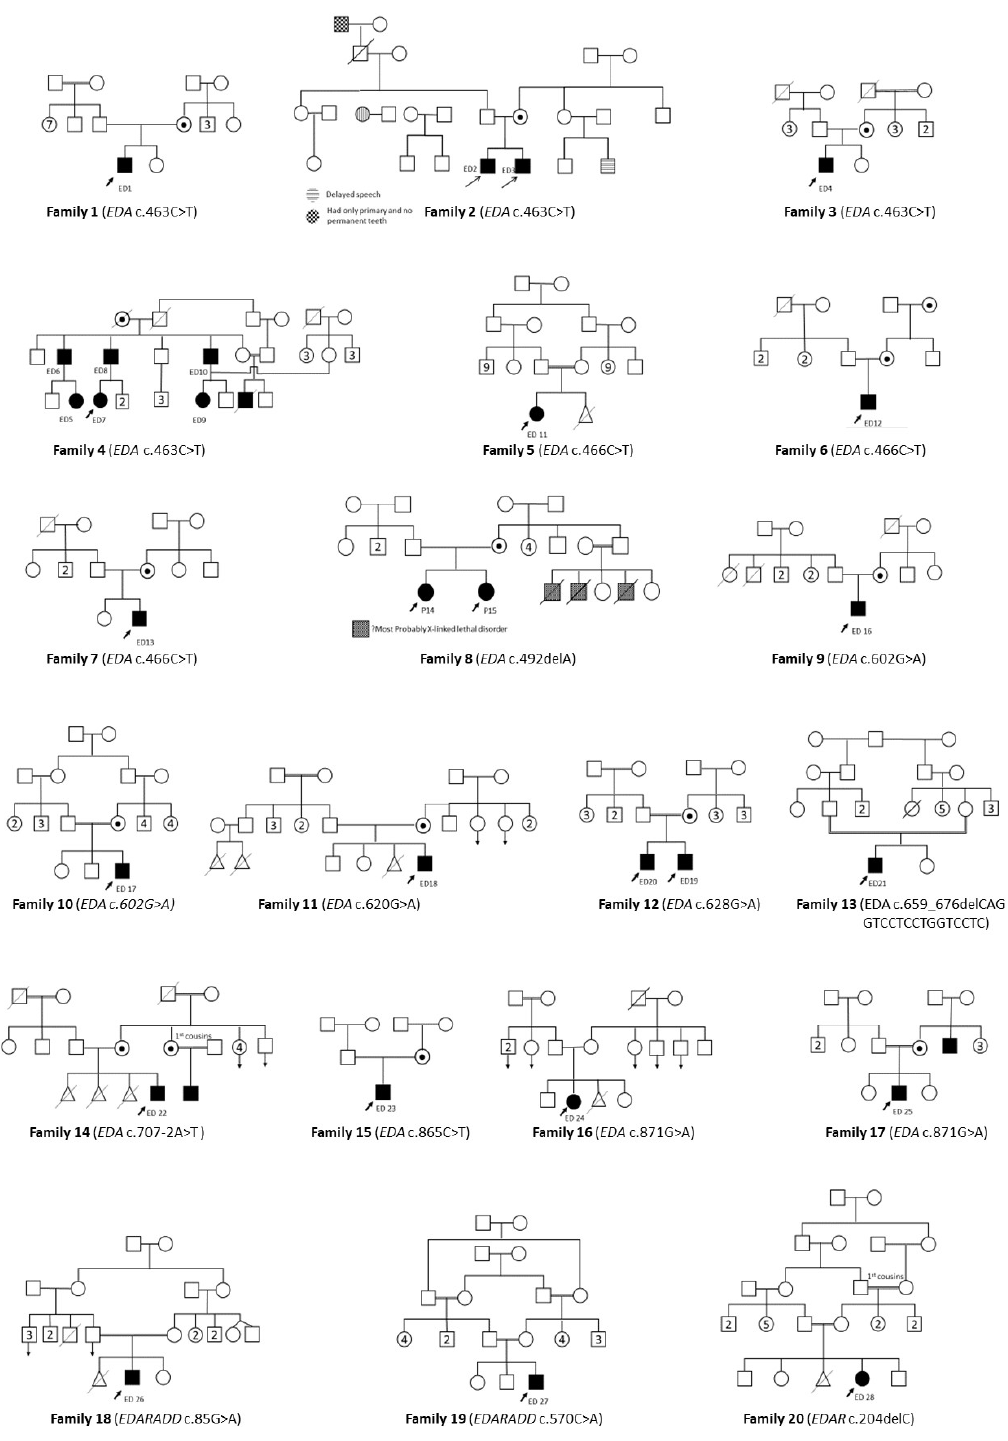
Figure 1. Pedigrees of molecularly identified ED patients. The figure shows 20 family pedigrees of 28 molecularly identified ED patients (ED1-ED28). Probands are denoted by black arrows, and the identified mutation is shown below each